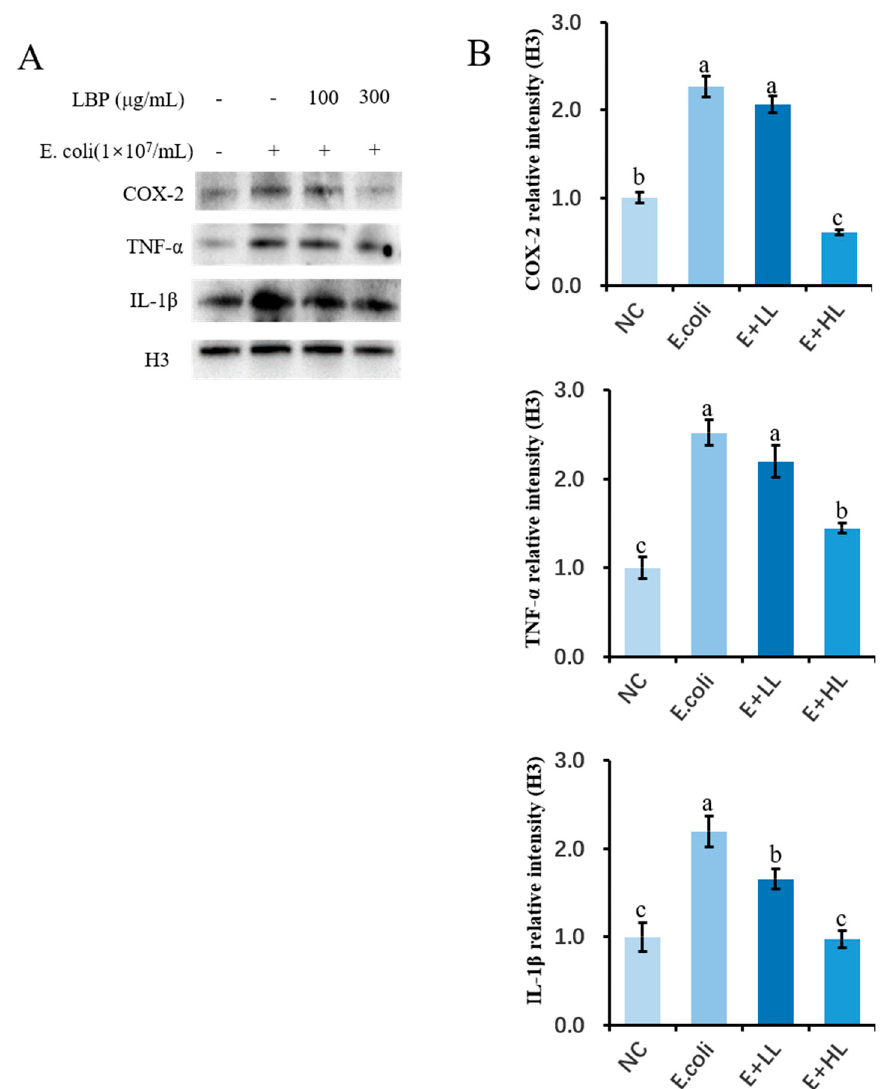
Figure 6. Effects of LBP on inflammatory factor protein expression. pbMEC were treated with different doses of LBP at 100 µ g/mL or 300 µ g/mL, followed by a challenge with 1 × 10 7 /mL E. coli for an additional 6 h. ( A ) Western blots of COX-2, IL-1 β , and TNF- α . ( B ) Relative protein abundance of COX-2, IL-1 β , and TNF- α to Histone H3. Results are expressed as means ± SEM. Results are presented as means ± SEM. Superscripts represent that the difference between groups was significant according to statistical analysis ( p < 0.05).